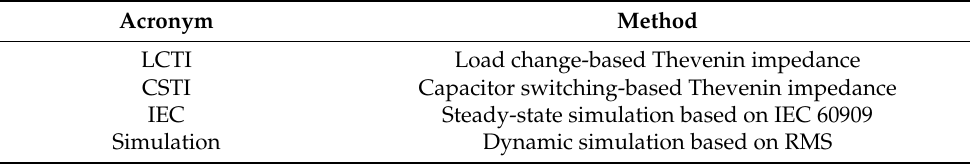
Table 4. Abbreviations of fault level calculation methods.